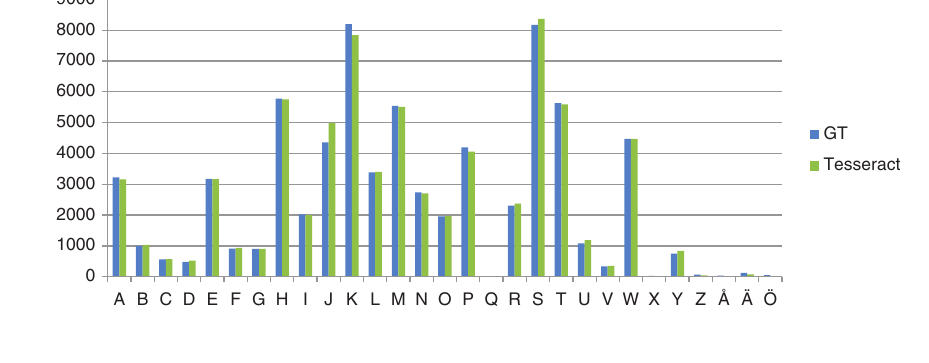
Fig. 5: Lower case letters of ground truth and